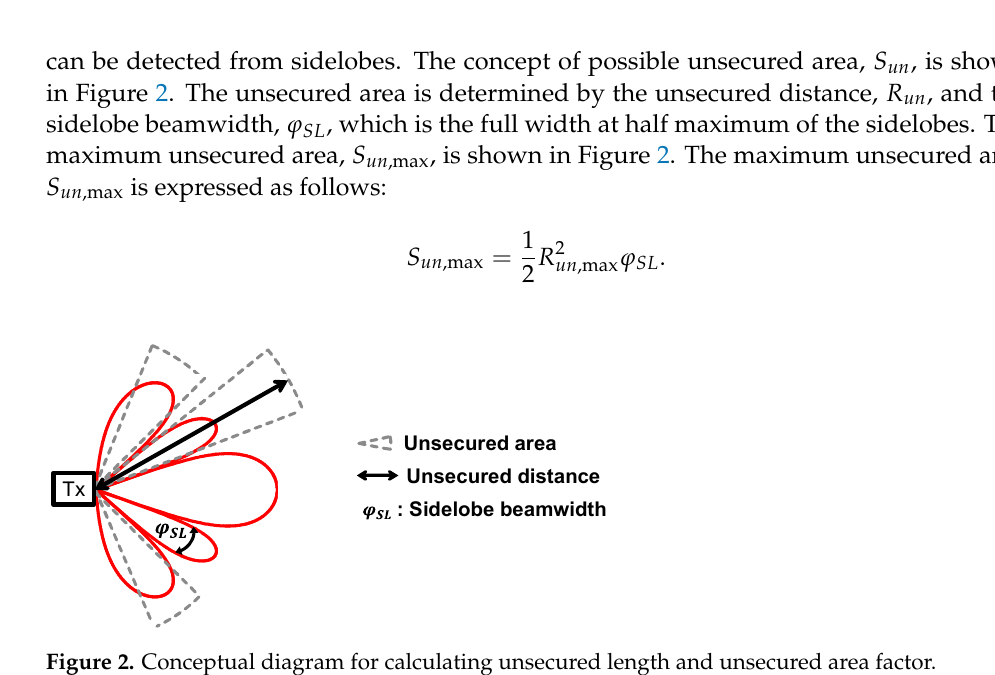
Figure 3. Schematic of OPA-based OWC with OIL semiconductor lasers. ML: master laser, SL: slave laser, OIL laser: optically injection-locked laser, PM: phase modulation, AM: amplitude modulation.